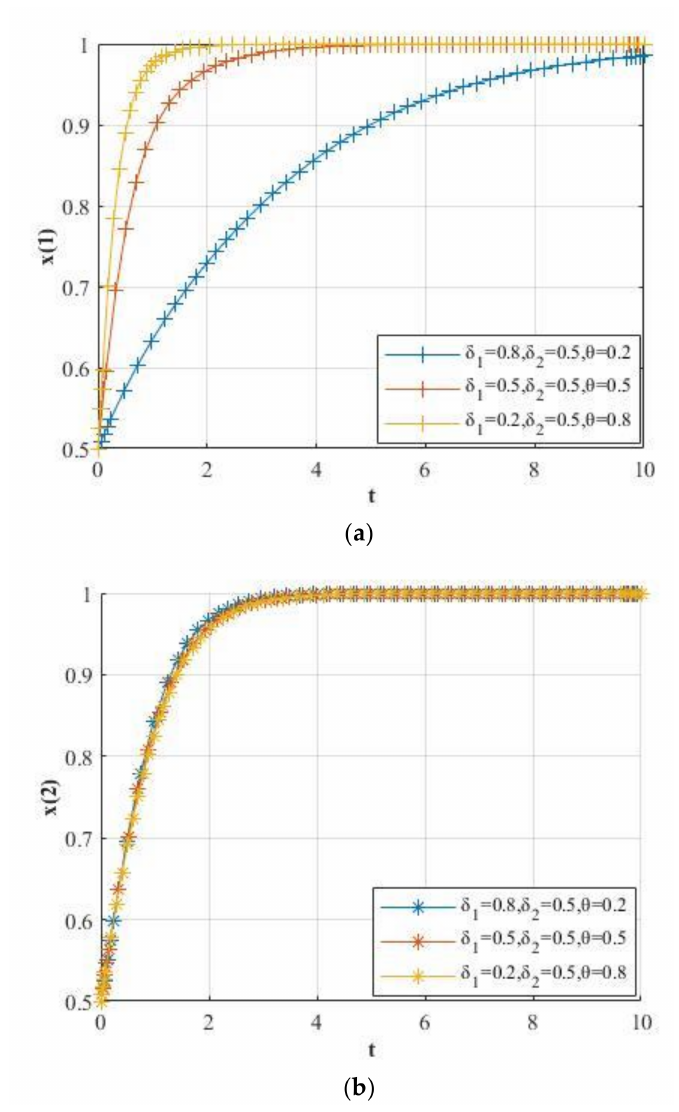
Figure 11. ( a ) While changing δ 1 , θ , and δ 2 = 0.5, evolution diagram of government’s supervision option. ( b ) While changing δ 1 , θ , and δ 2 = 0.5, evolution diagram of platform’s supervision